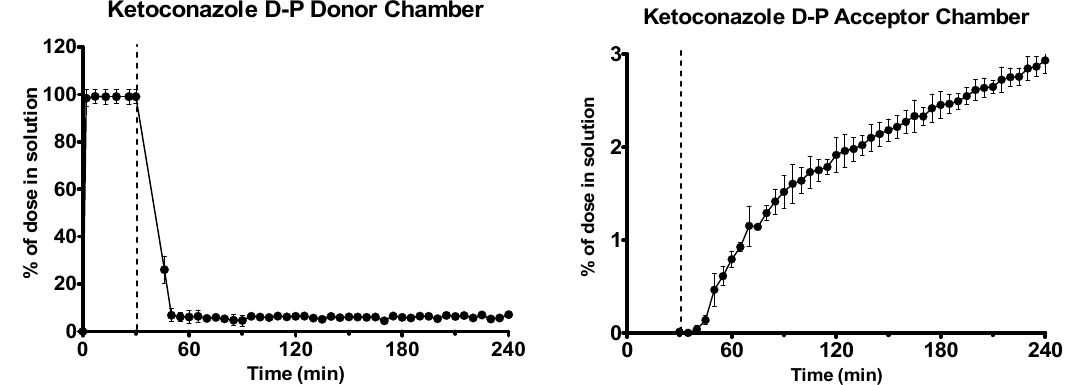
Figure 8. Drug release time profile for the ketoconazole dose equivalent to 10 mg API using the D-P apparatus. Left: Percentage release profile in the donor chamber. Right: Percentage release profile in the acceptor chamber. Dotted line indicates transition from gastric sector to intestinal sector. Each data point represents the mean ± SD ( n = 3).